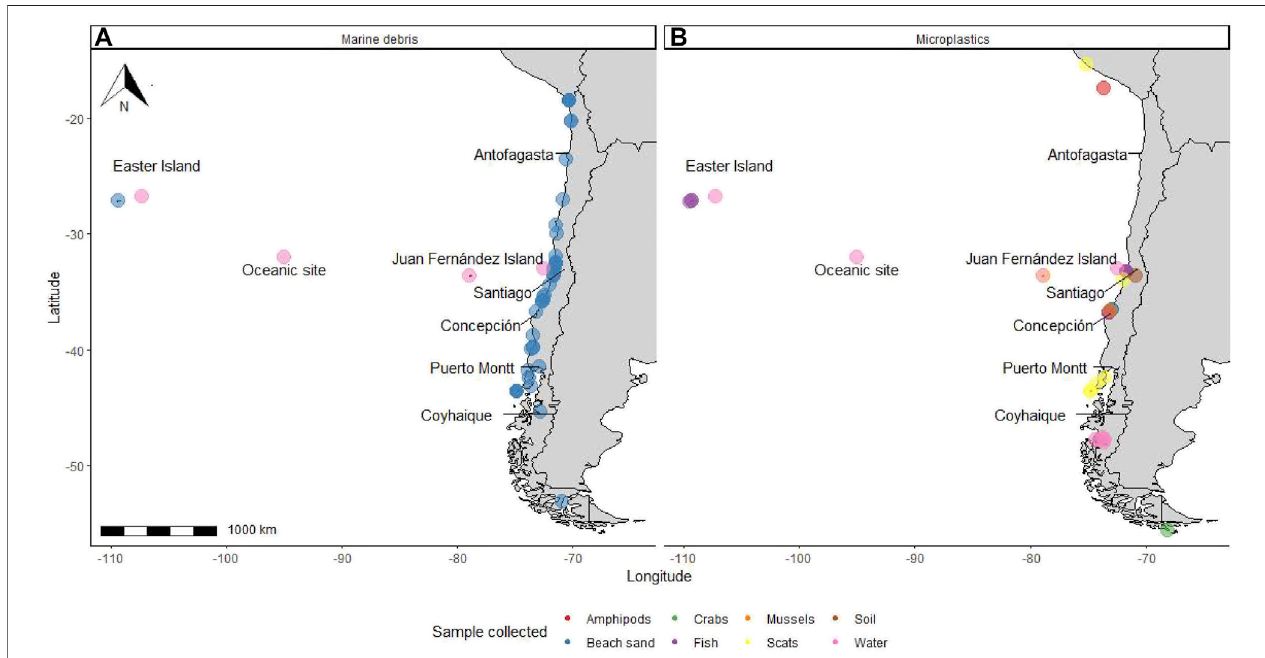
FIGURE1| Distributionand bio-occurrence of (A) .marine debris,and (B) .microplasticsalongcontinental and insular Chile.The colorsindicate the type ofsample analyzed (biotic and abiotic).